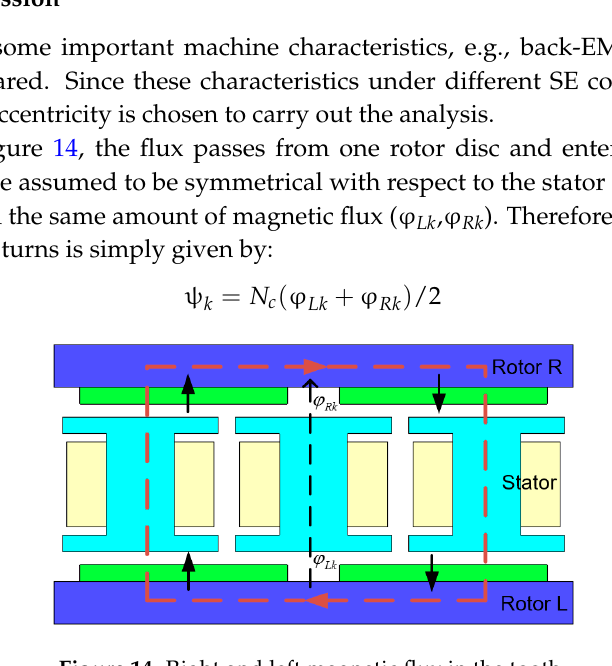
Figure 14. Right and left magnetic flux in the tooth.